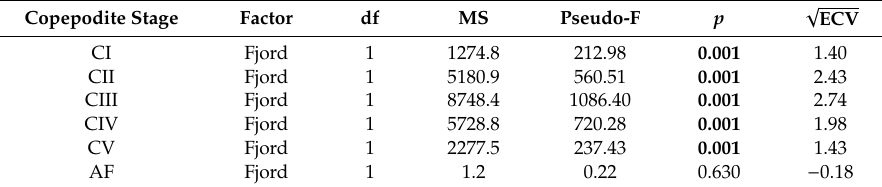
Table 1. Results of one-factor multivariate PERMANOVA for the prosome length of Calanus copepodite stages in Hornsund and Kongsfjorden. Bold means p < 0.05, df are degrees of freedom, MS represents √ means of squares, ECV are square root of the estimated components of